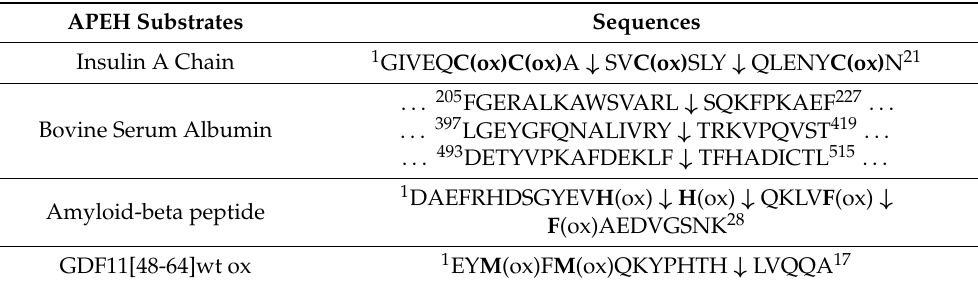
Table 3. Sequences of APEH endoprotease substrates with the indication of the amino acids whose oxidation has been experimentally verified (X(ox)), the residues more prone to oxidation (X), and the identified cleavage sites ( ↓ ). The subscript numbers indicate the position of the peptides respect to the full sequences. Bold indicates oxidized amino acids that are experimentally verified; background color indicates residues more prone to